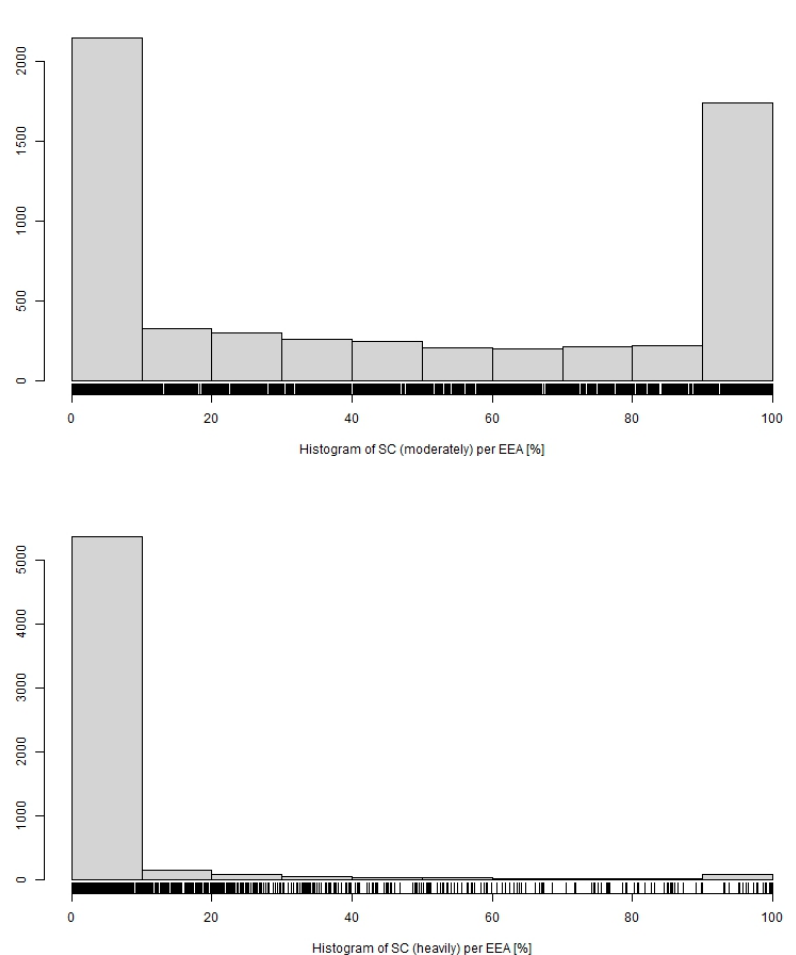
Figure 10. Distribution of EEAs by percentage of SC (slightly, moderately, heavily). Characteristics of horizontal axis SC (slightly) are as follows: Min.: 0.00%; Q1: 0.00%; Median: 55.30%;